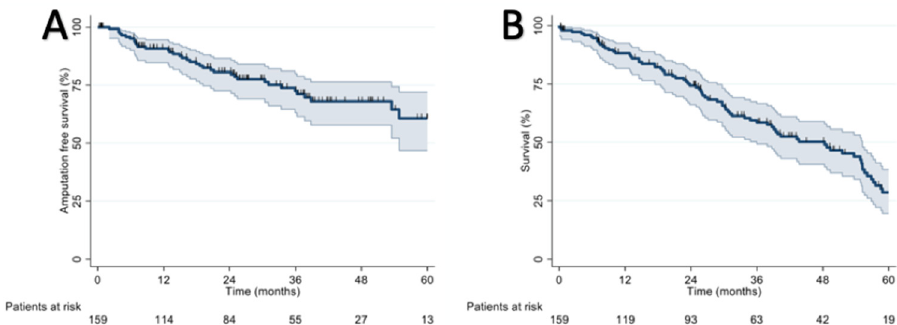
Figure 6. ( A ) Amputation-free survival rates and ( B ) survival rates .